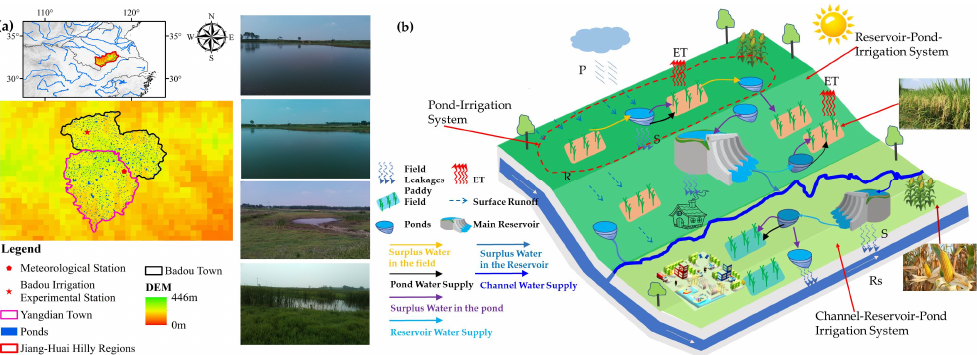
Figure 1. Location of the study area ( a ) and diagram of Pond-Irrigation system in the Jiang-Huai hilly region ( b ).